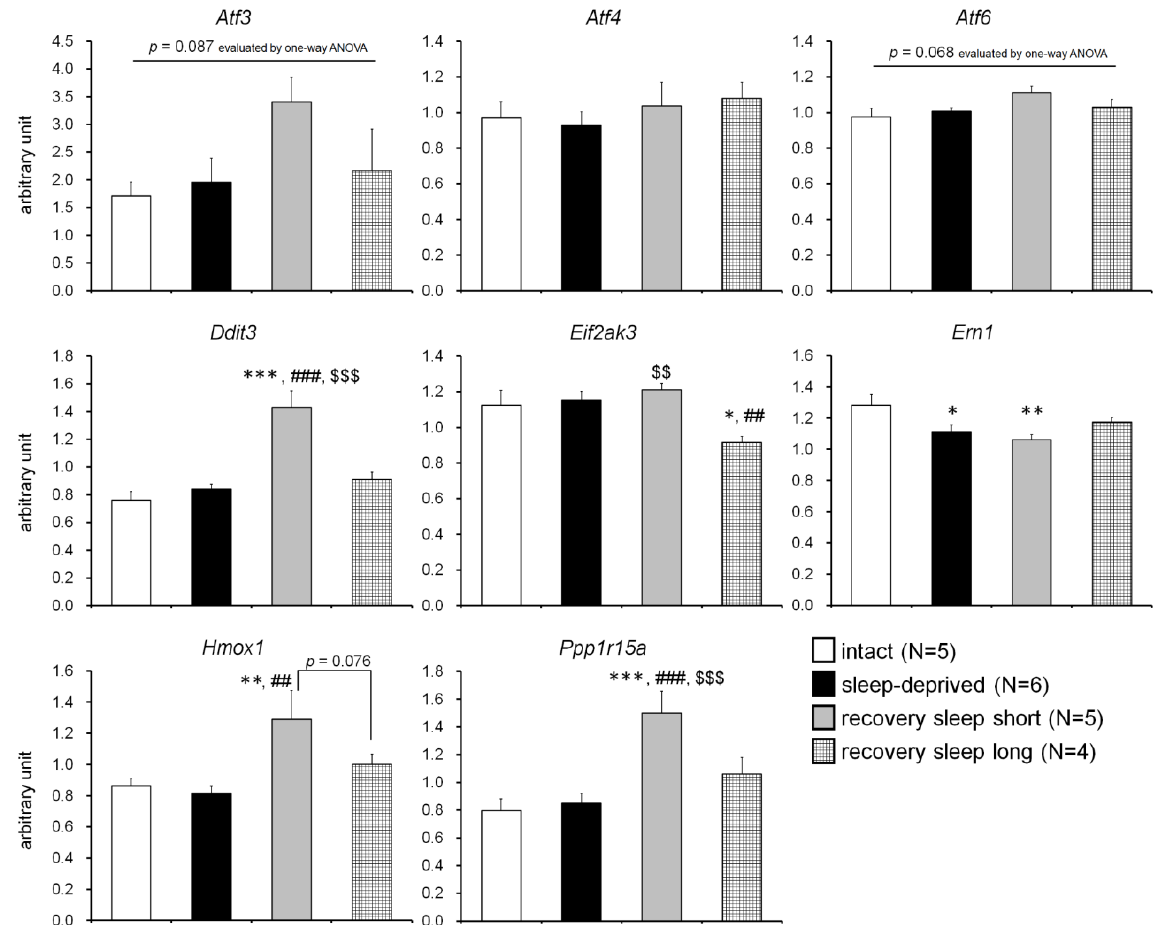
Figure 1. Effects of sleep deprivation and recovery sleep on integrated stress response (ISR)- and unfolded protein response (UPR)-related gene transcript levels of the rat liver. For the ISR-related gene ( Atf3 , Atf4 , Ddit3 , Hmox1 , and Ppp1r15a ), all transcript levels except for the Atf4 gene were higher in the recovery sleep short group compared to other three groups. In contrast, sleep deprivation and recovery sleep modestly affected the expression levels of the UPR-related gene ( Atf6 , Eif2ak3 , and Ern1 ) transcripts. *, **, ***: p < 0.05, p < 0.01, p < 0.001 vs. intact group; ##, ###: p < 0.01, p < 0.001 vs. sleep-deprived group; $$, $$$: p < 0.01, p < 0.001 vs. recovery sleep long group.